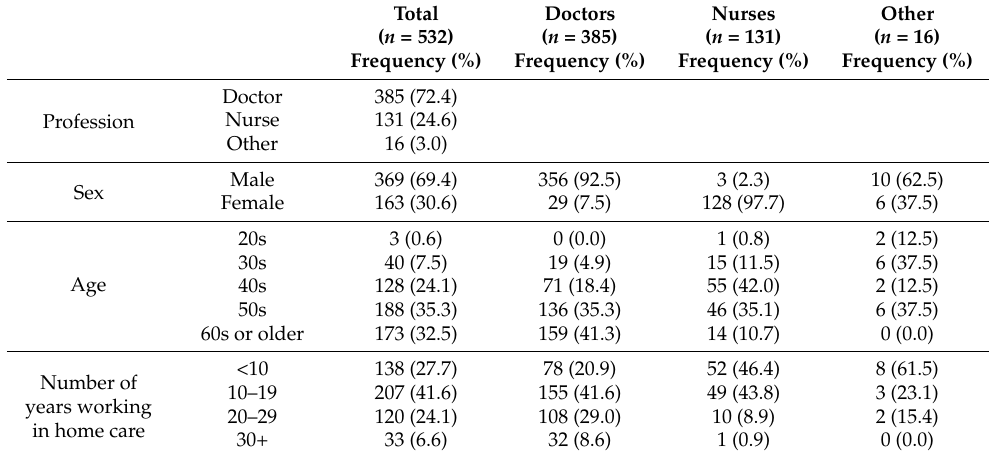
Table 1. Characteristics of